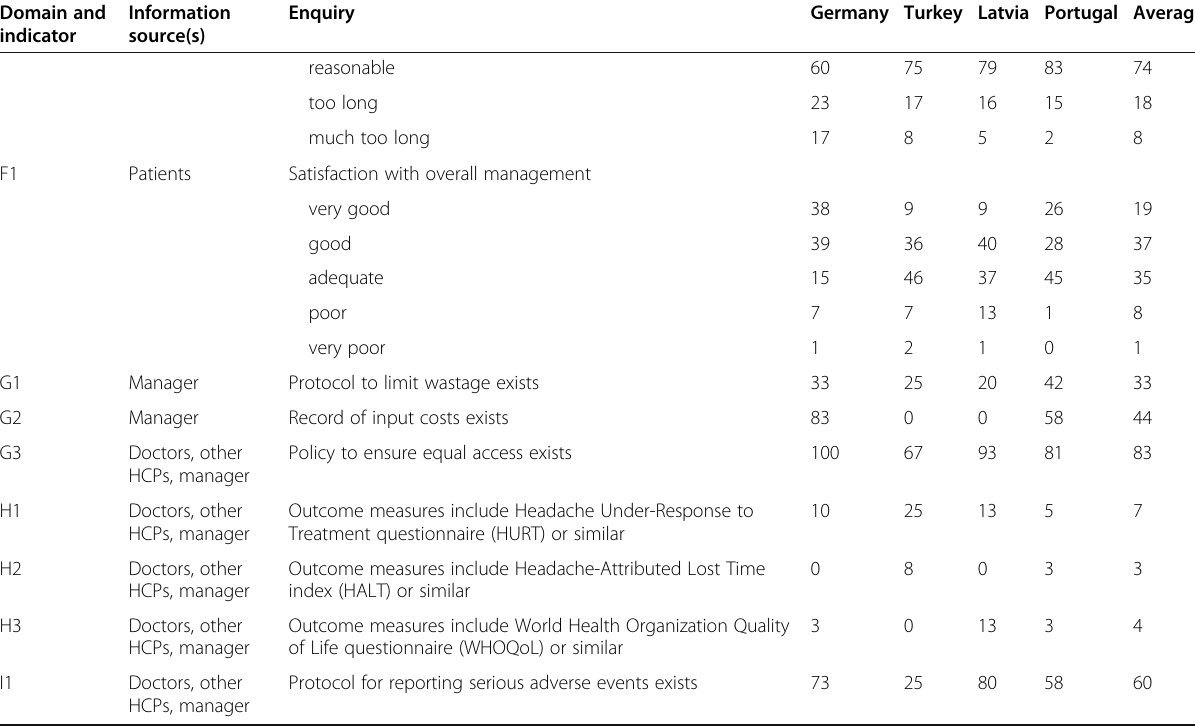
Table 3 Responses to questionnaire enquiries (% of positive answers, except where specified) (Continued) Domain and